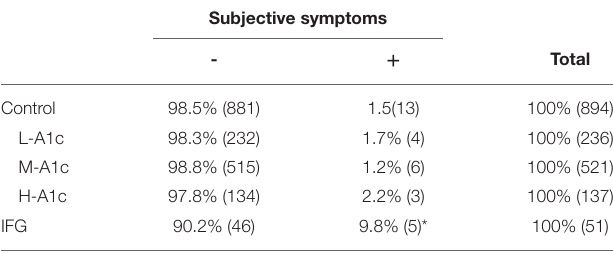
TABLE 6 | Correlation of HbA1c and IFG with subjective neuropathic symptoms. Subjective